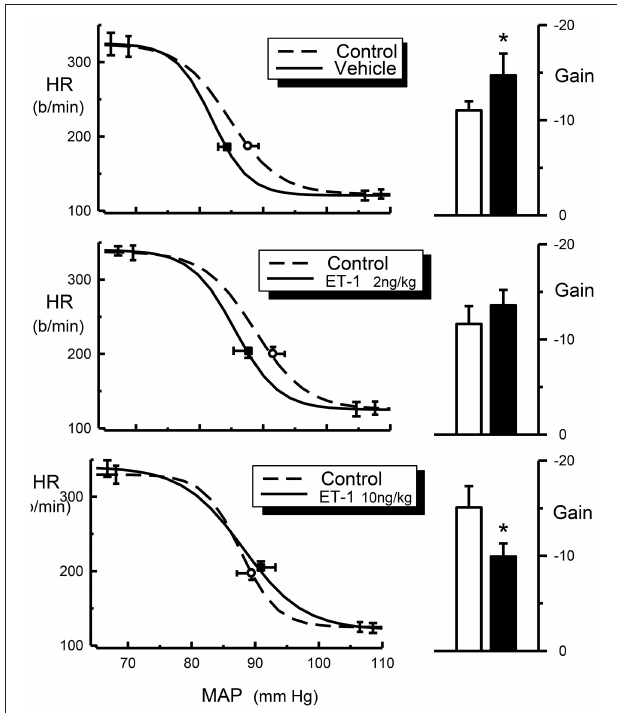
FIGURE 4 | Average HR baroreflex curves (left panels) from control (dotted line), ET-1 treated rabbits (2 ng/kg and 10 ng/kg, solid line) and histograms (right panels) for baroreflex gain (b/min/mmHg) from control (open bars) and ET-1 treated rabbits (2 ng/kg and 10 ng/kg, filled bars). Resting points are indicated by open circle (control) or square symbols (Et-1 Treated). Error bars are SEM, indicating variation between animals. * P <